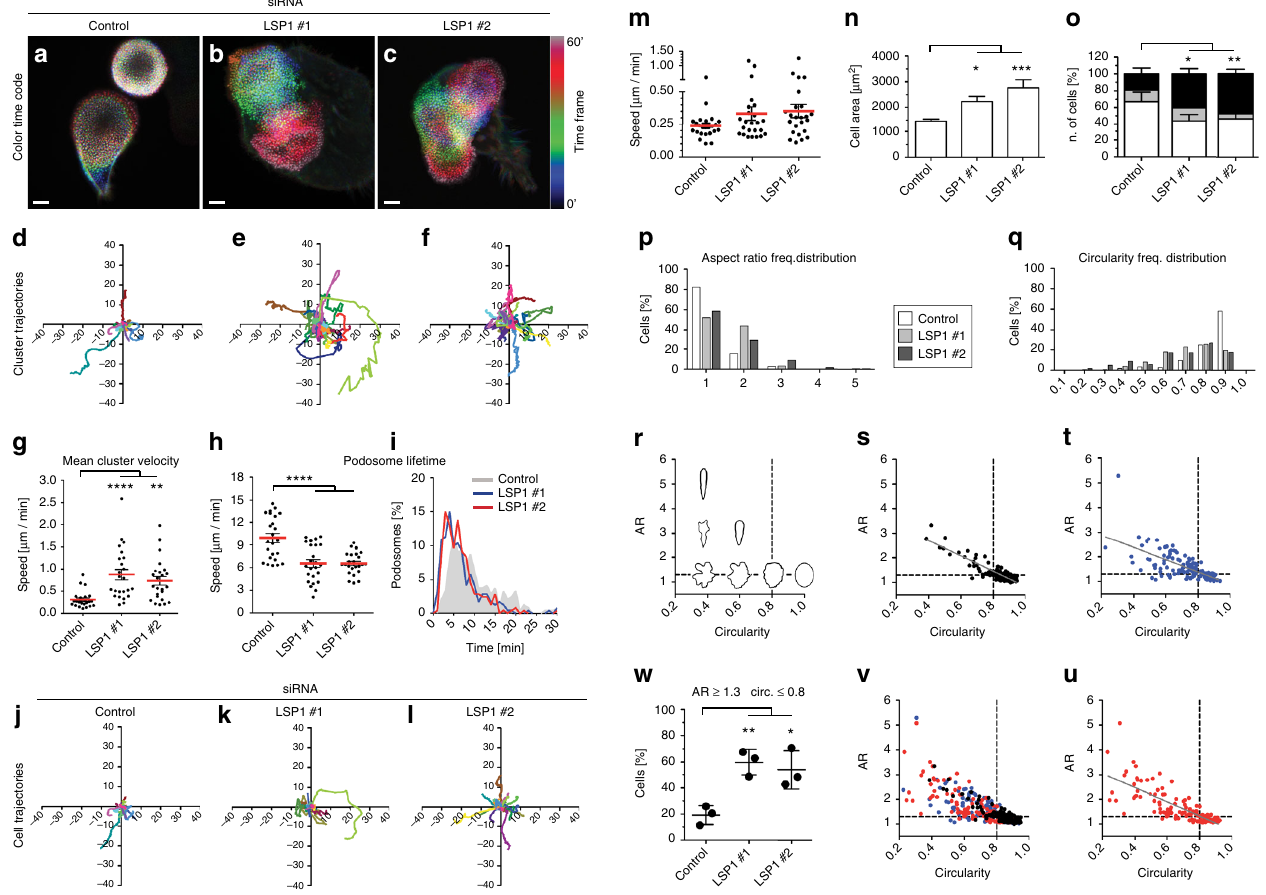
Fig. 2 LSP1 depletion leads to enhanced dynamics of podosomes, podosome clusters and cells. a – c Still images from confocal time lapse videos, frames were progressively colored along the spectrum, with fi nal merges presented. Scale bars: 10 µ m. See Supplementary Movies 2 – 4. d – f Colored lines track centers of mass of podosome clusters from cells of four different donors. Axes indicate relative position in µ m. g Velocity of podosome clusters ( µ m min − 1 ), in 24 cells from four different donors. Dots represent mean cluster velocity of single cells. h , i Podosome lifetime, with 240 podosomes evaluated per condition. Dots in h represent mean values of 10 podosomes in single cells. i Frequency distribution of podosome lifetime. j – l Coloured lines track centers of mass of cells from four different donors. Axes indicate relative position in µ m. m , n Graphs show speed ( µ m min − 1 ) ( m ), or total area ( µ m 2 ) ( n ) of cells treated with indicated siRNAs. Dots represent mean value of single cells ( n = 24), each bar represents mean value of 24 cells from four different donors. o – w Cell morphology in control and LSP1 knockdown cells. o Podosome distribution, with cells scored in groups, according to even distribution (white), recruitment of podosomes to single leading edge (grey) and formation of clusters (black). Values represent the percentage of at least 50 cells per donor ( N = 3). p , q Frequency distribution for aspect ratio ( p ) or circularity ( q ), with 123 cells from three different donors evaluated. r – v Scatter plots of circularity ( x -axes) and aspect ratio ( y -axes), with schematic graph depicting respective cell shapes ( r ), and plots for cells treated with control siRNA ( s ), LSP1- speci fi c siRNAs ( t , u ), and merge ( v ). Cut-off values of 1.3 for aspect ratio and 0.8 for circularity: dashed lines, regression line in grey. Dots represent single cells ( N = 123) from three donors. ( w ) Percentage of cells showing aspect ratio ≥ 1.3 and circularity ≤ 0.8. Dots represent mean percentages calculated with at least 35 cells per donor ( N = 3). a – w Treatment with speci fi c siRNAs is indicated. Values are given as mean ± s.e.m. Statistical test: one-way ANOVA. *P < 0.05, **P < 0.01, ***P < 0.001, **** P < 0.0001. For speci fi c values, see Supplementary Data